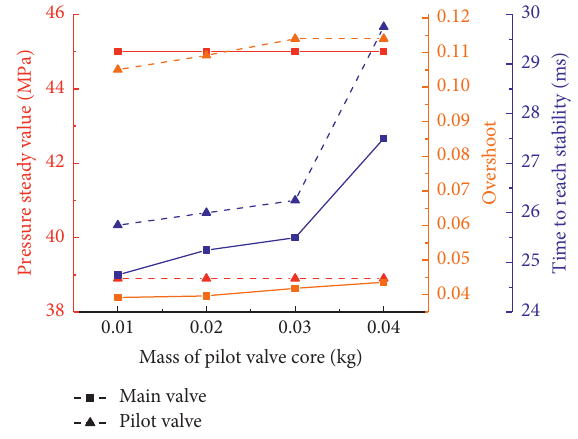
Figure 13: Dynamic response